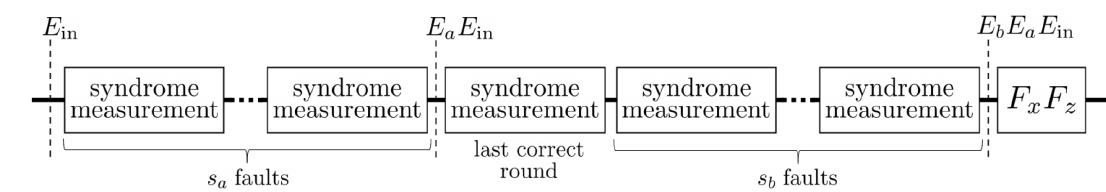
FIG. 14. Fault-tolerant error-correction protocol for a capped color